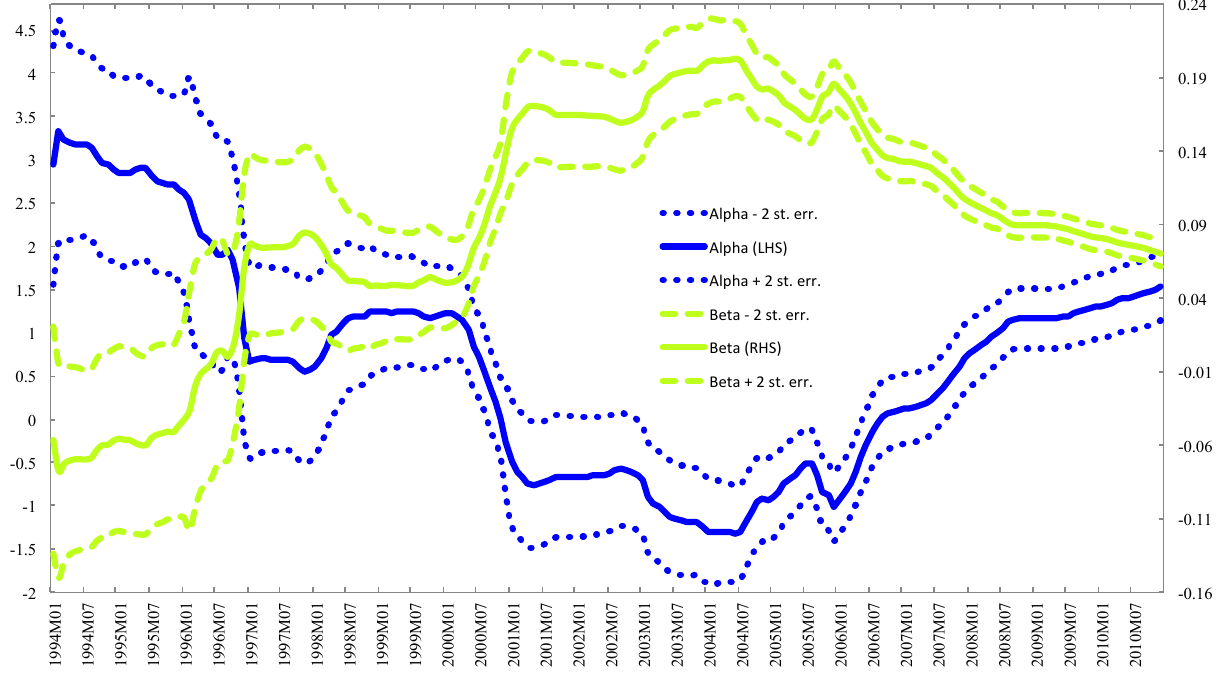
Figure 4. The recursive OLS estimates of the regression of Henry Hub natural gas prices on oil prices. On the left-hand side (LHS), the intercept of the regression is measured in dollars per million British thermal unit (MMBtu), and on the right-hand side (RHS), the slope (beta) is measured in MMBtu per barrel. The plus/minus two standard error bands are also presented for both